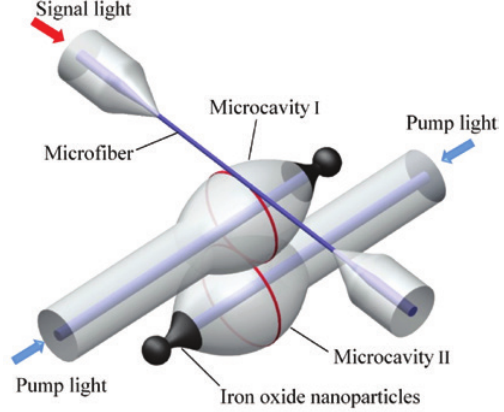
Figure 1: Schematic of all-optical controllable EIT based on coupled silica microbottle